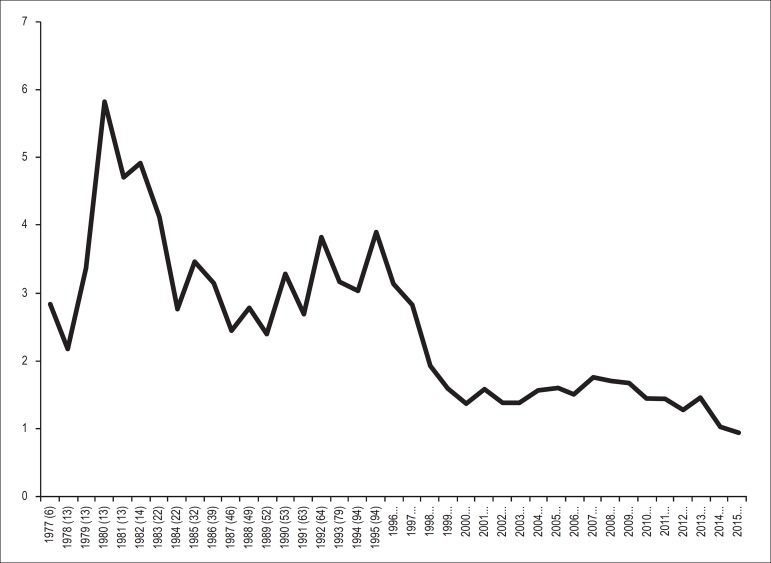
Number of publications from 1977 to 2015 adjusted for the number of
postgraduate students with a theoretical capacity to publish.